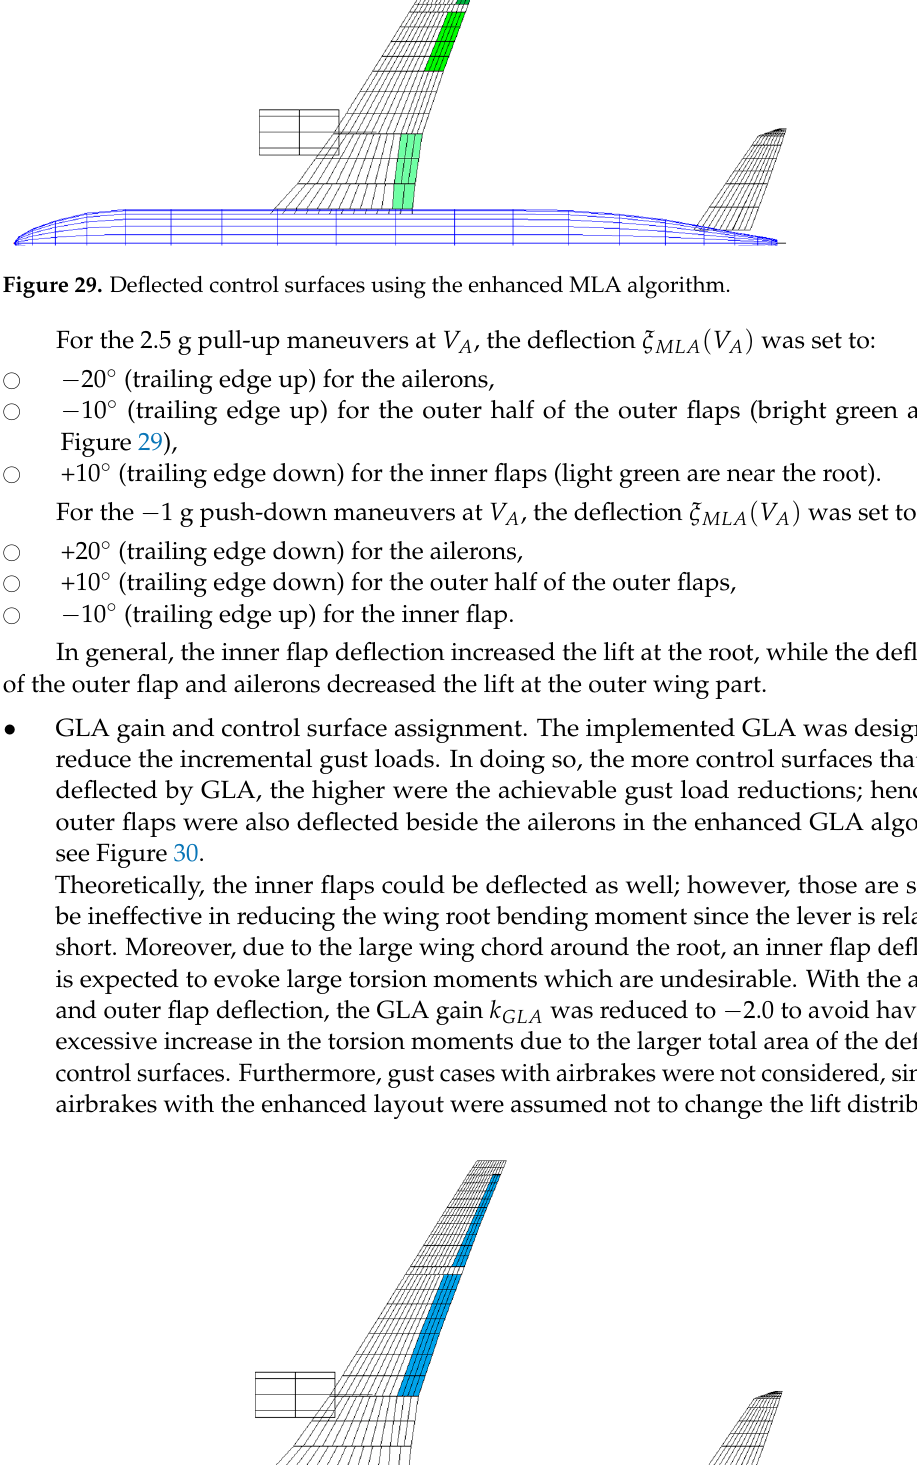
Figure 30. Deflected control surfaces using the enhanced GLA algorithm.